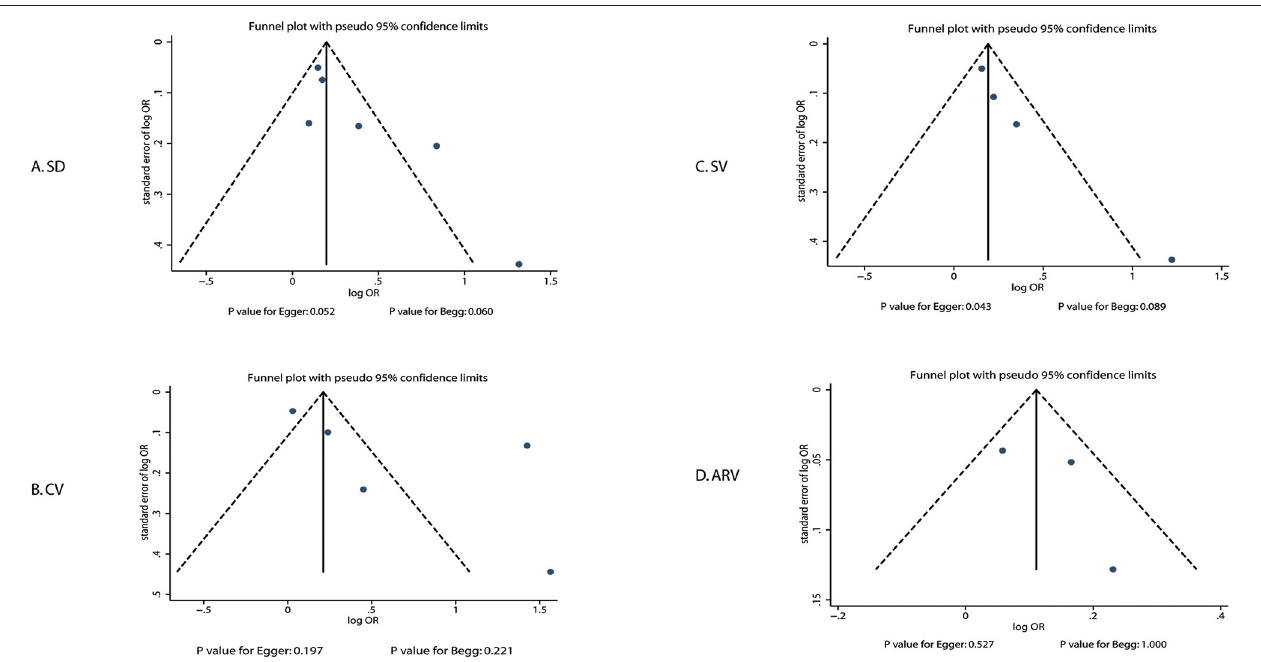
FIGURE 4 | Publication biases for the association between systolic BP variability and poor functional